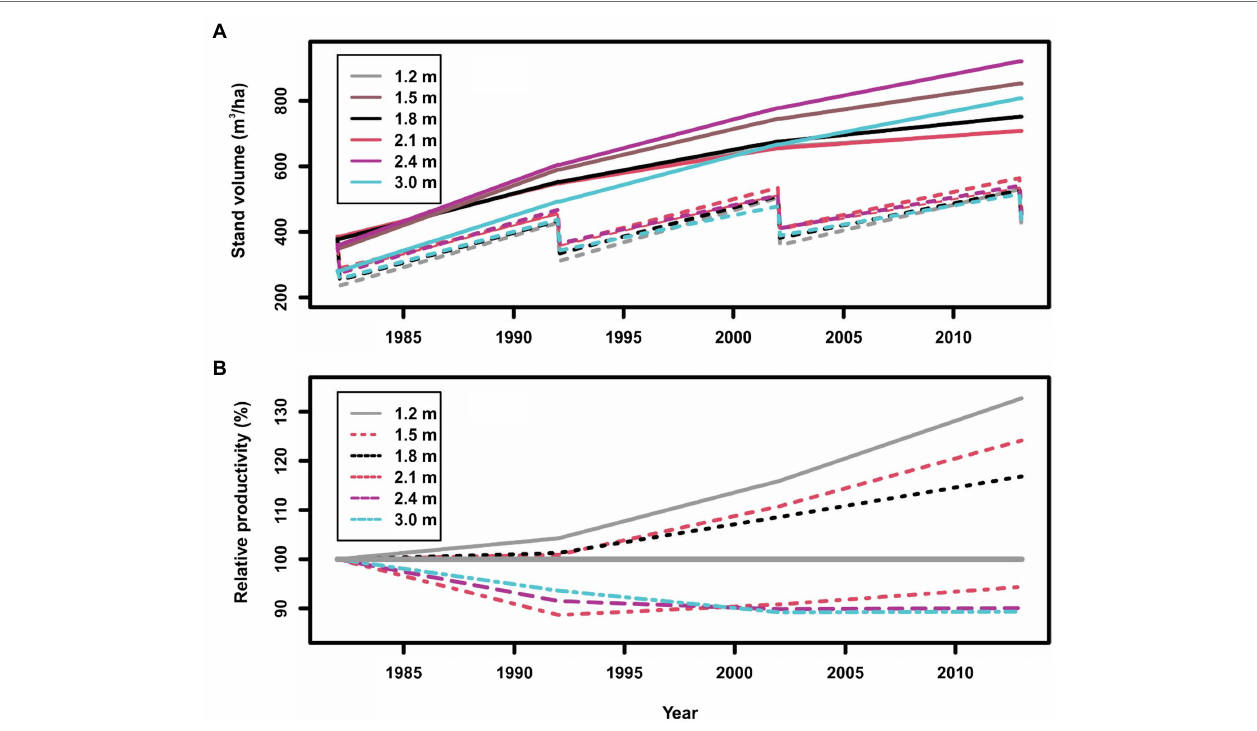
FIGURE 4 | Stand gross volumes ( A : in which solid lines indicate control plots, and dashed lines indicate thinned plots) and relative productivity (volume growth) ( B : in which the line of 100% indicates the control plots, >100% indicates overcompensation, and <100% indicates under compensation) of planted red pine ( Pinus resinosa Aiton) under different spacing regimes created by initial planting density and thinning in Chalk River, Ontario,